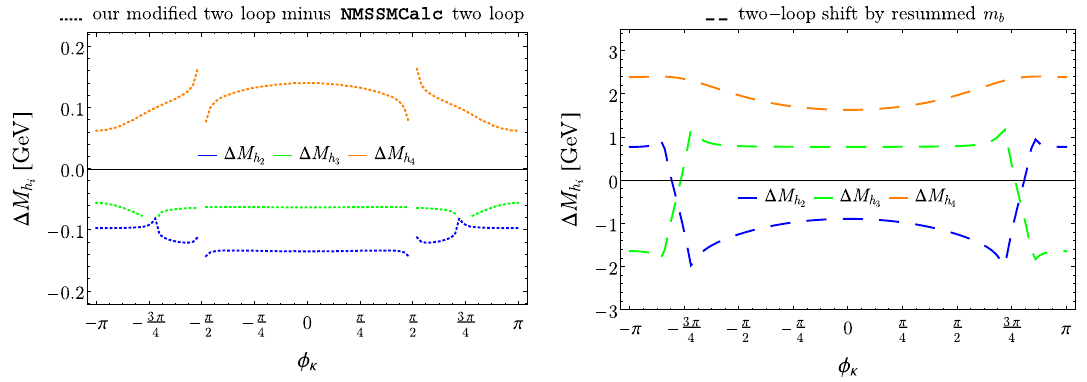
Fig. 8 Impactofthehigher-ordereffectsinthemasspredictionsfor h 2 , h 3 and h 4 in the scenario of Fig. 7. On the left-hand side , we show the deviationinmassbetween NMSSMCALC andourmodifiedscheme(con- trolled by O (α t α s ) corrections beyond the MSSM-approximation). The plot on the right-hand side illustrates the impact of large-tan β effects